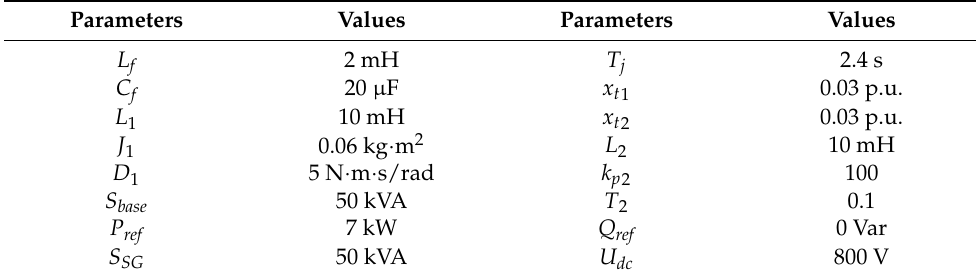
Table 1. Parameters of the VSG-SG coupling system.